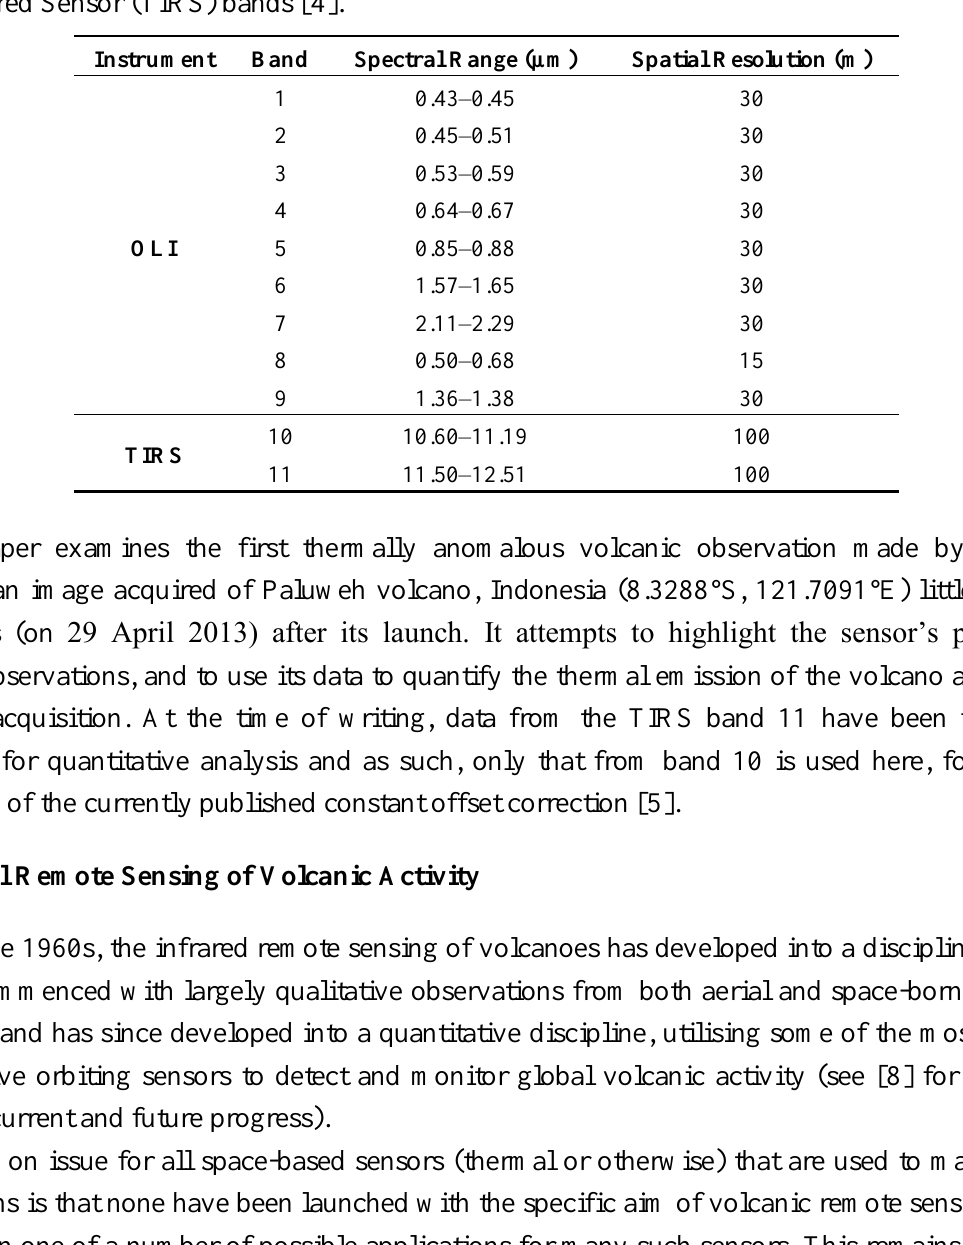
Table 1. Characteristics of the Landsat 8 Operational Land Imager (OLI) and Thermal Infrared Sensor (TIRS) bands